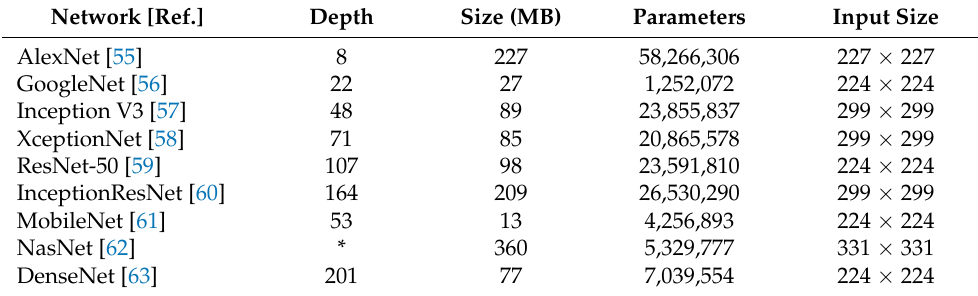
Table 3. Configuration and properties of each deep learning pre-trained model. Network